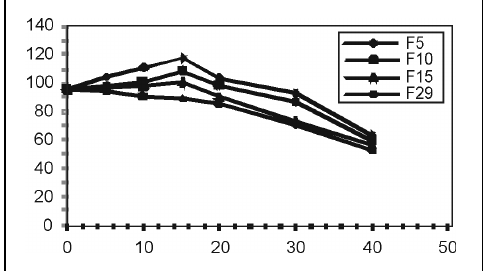
Fig. 6. Influence of filler concentration on 28-day com- pressive